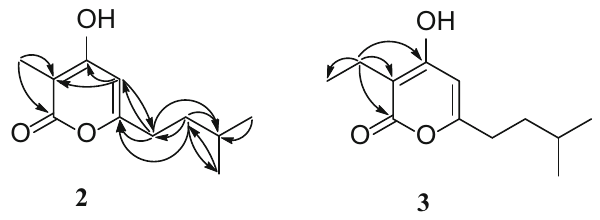
Fig. 3 Key HMBC correlations of 2 and 3